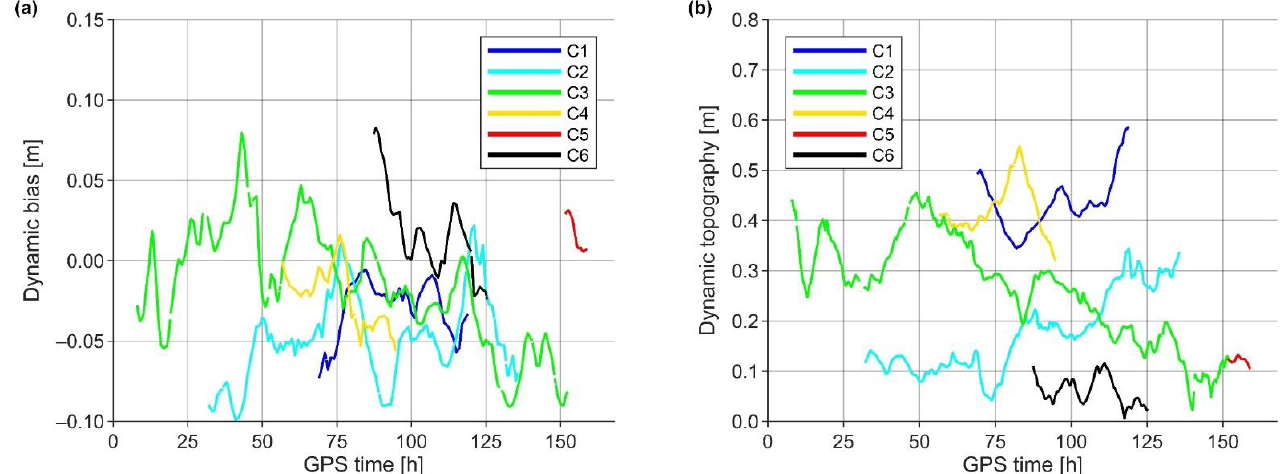
Figure 6. The ( a ) predicted DB and ( b ) corrected HDM-based DT during marine survey cam- paigns.